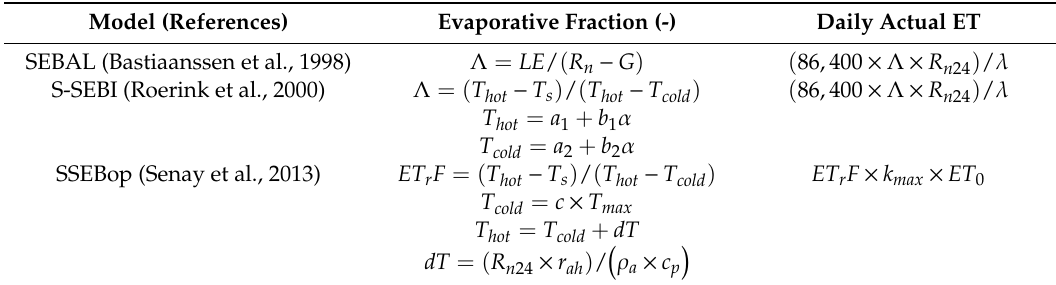
Table 6. The mathematical expressions used to compute the evaporative fraction and the daily actual evapotranspiration (ET) for the SEBAL, S-SEBI, and SSEBop models. Model (References) Evaporative Fraction (-) Daily Actual ET SEBAL (Bastiaanssen et al., 1998) Λ = LE / ( R n − G ) ( 86,400 × Λ × R n 24 ) / λ S-SEBI (Roerink et al., 2000) Λ = ( T hot − T s ) / ( T hot − T cold ) ( 86,400 × Λ × R n 24 ) / λ T hot = a 1 + b 1 α T cold = a 2 + b 2 α SSEBop (Senay et al., 2013) ET r F = ( T hot − T s ) / ( T hot − T cold ) ET r F × k max × ET